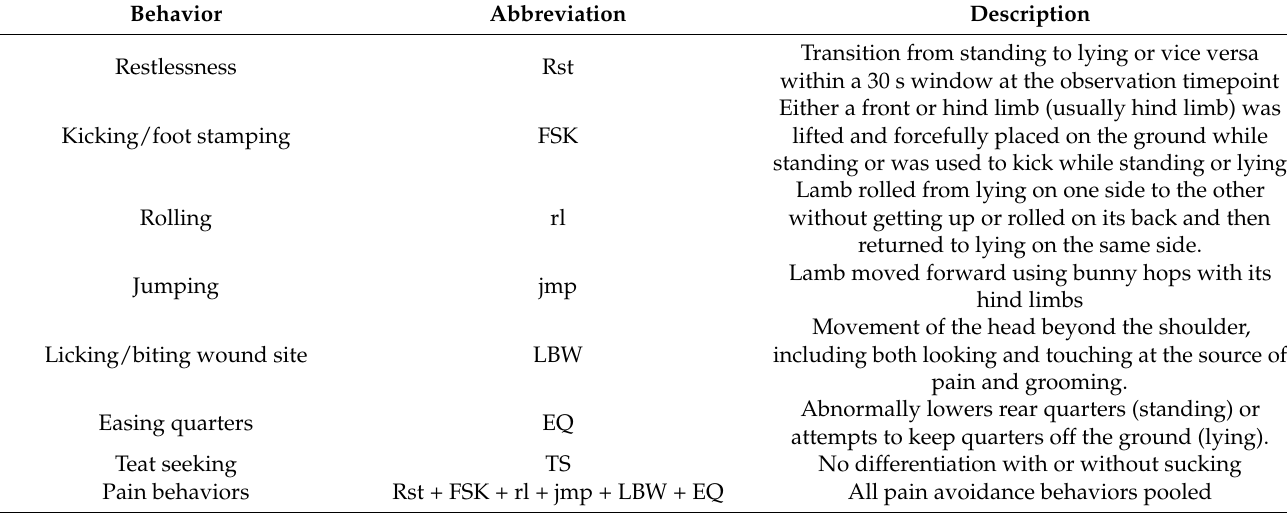
Table 1. Descriptions of active pain avoidance behaviors recorded during the experiment.